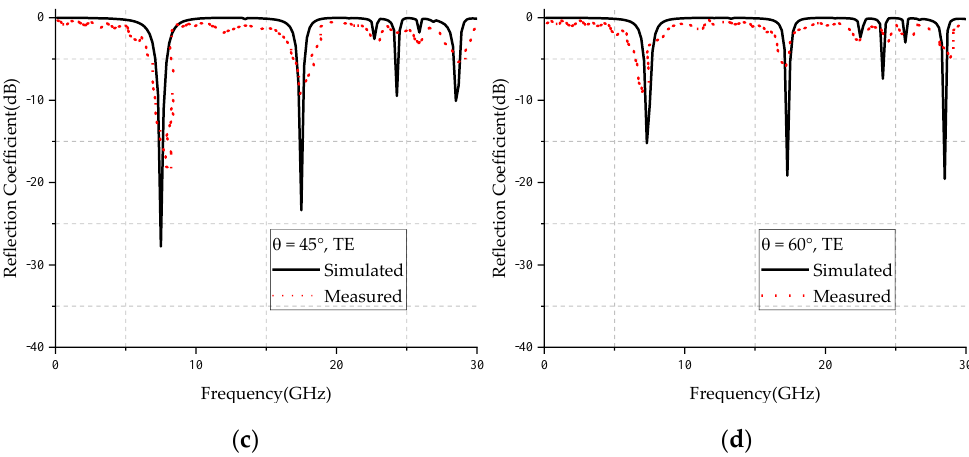
Figure 13. Comparison of simulated and measured results of TE wave incident at: ( a ) 0 degrees , ( b ) 30 degrees , ( c ) 45 degrees , and ( d ) 60 degrees .